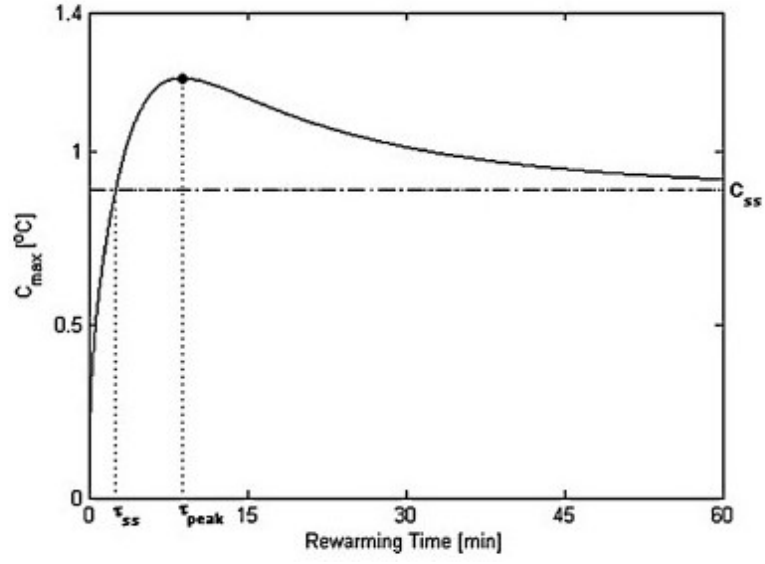
Figure 8. A phase of breast warming [17].